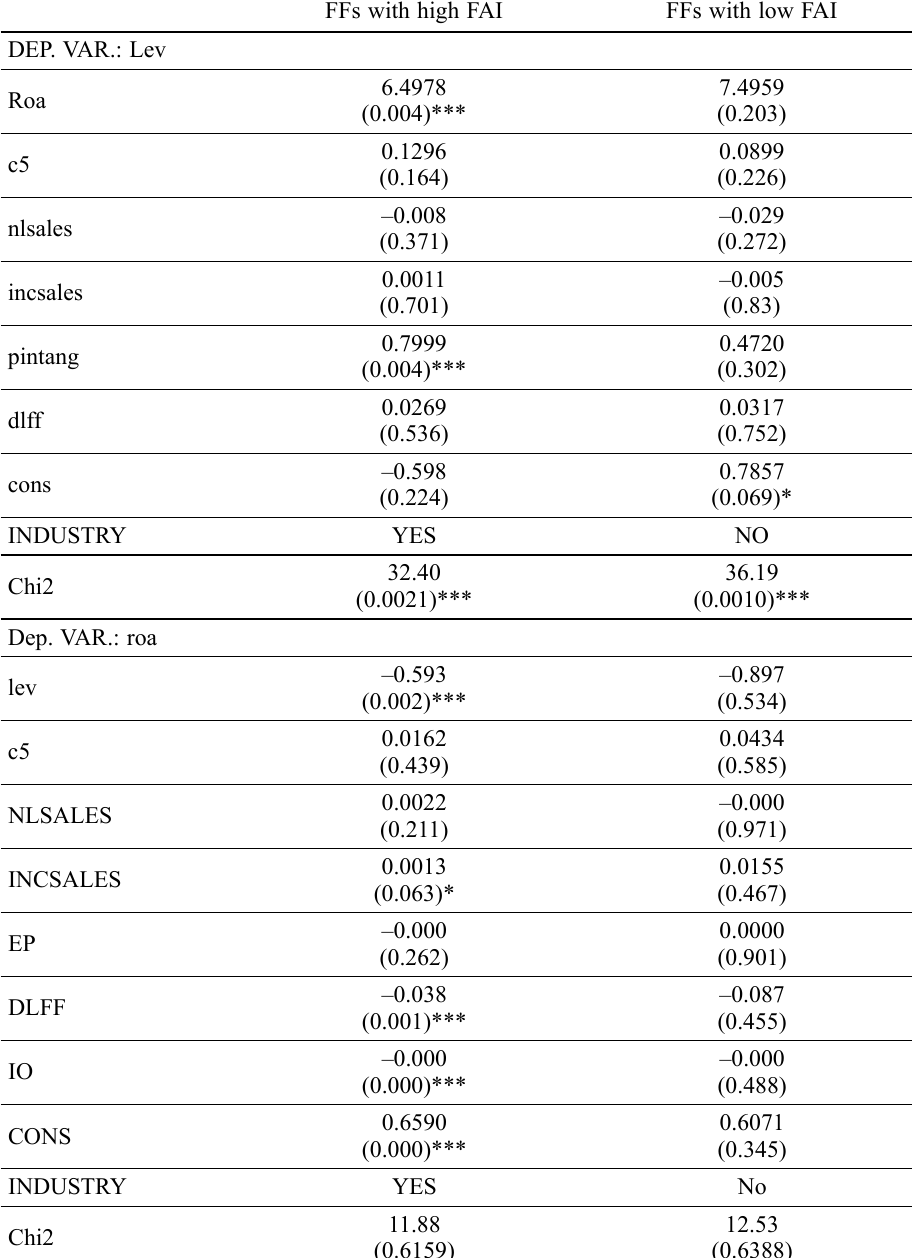
Table 5. Results from the simultaneous equations model. FFs with high vs. low Family Activism